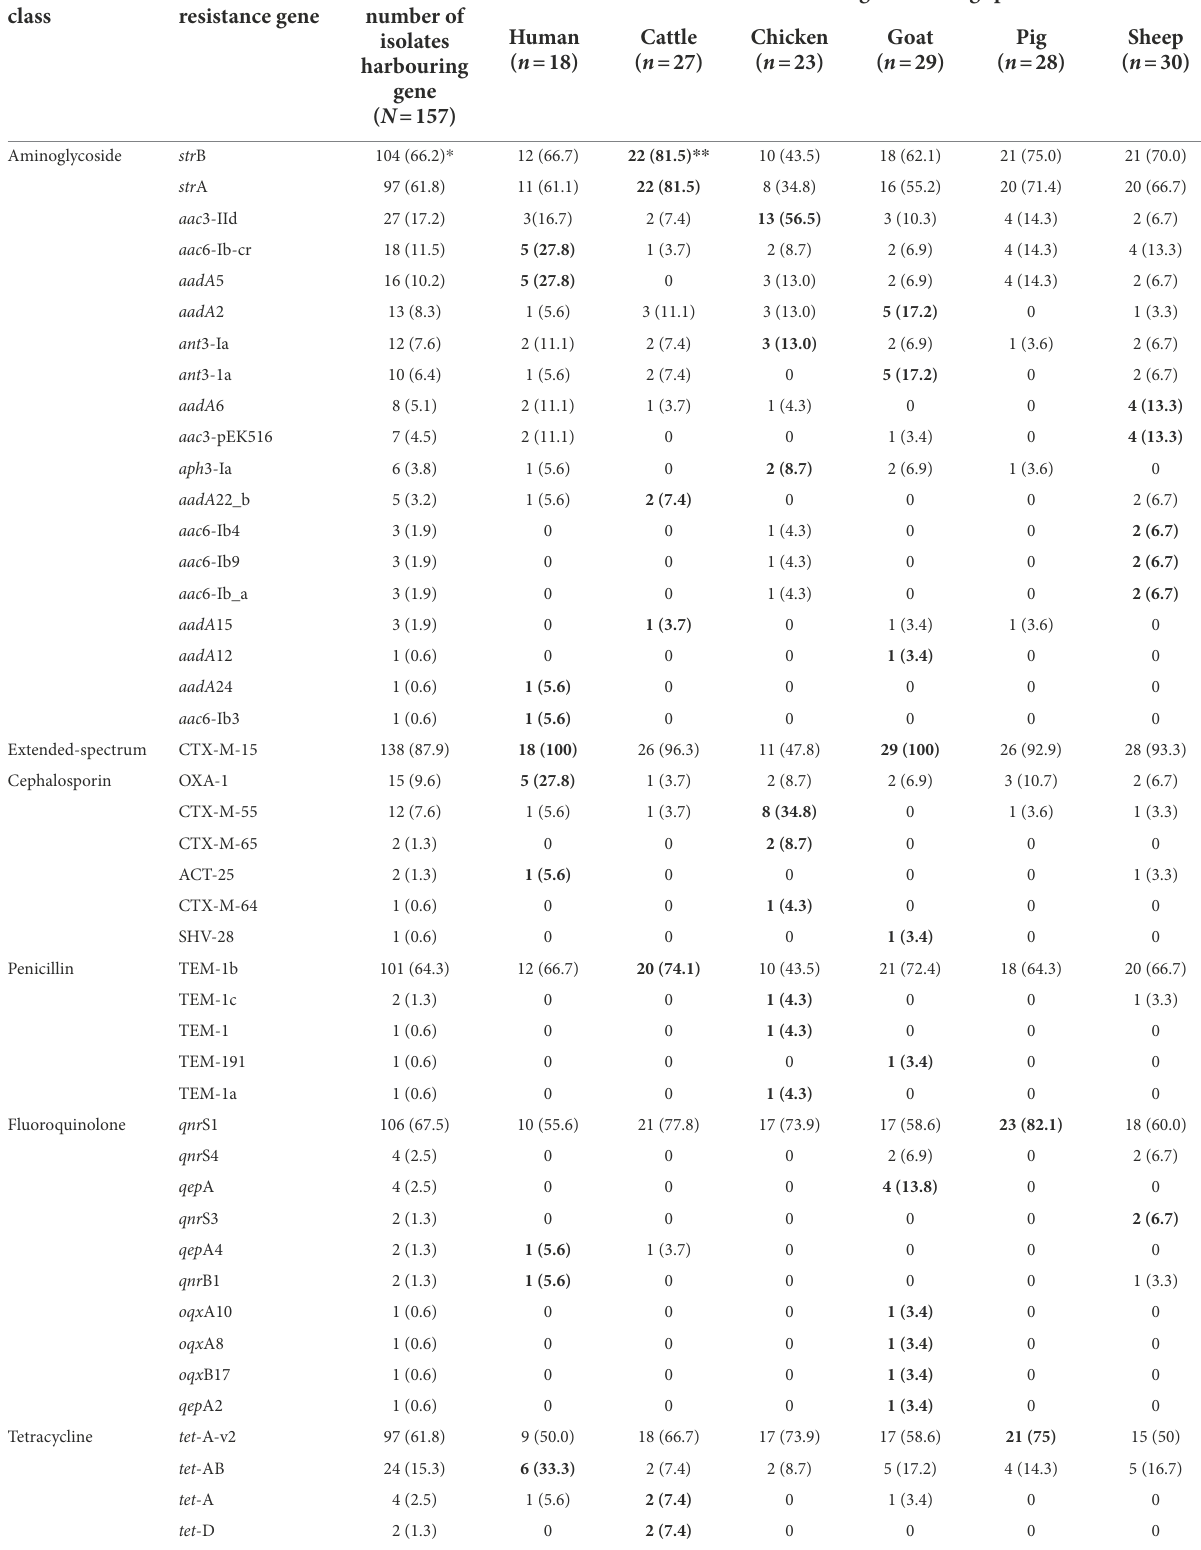
TABLE 2 Antimicrobial resistance genes detected in ESBL E. coli isolates from livestock and in-contact humans in Southeast Nigeria. Antimicrobial Antimicrobial class resistance gene